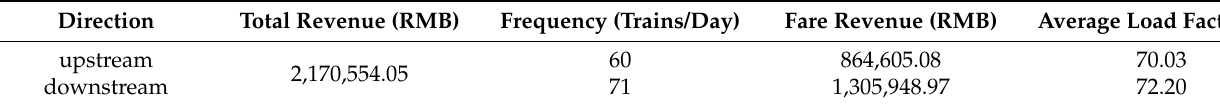
Table 4. Indicators of the line planning scheme.